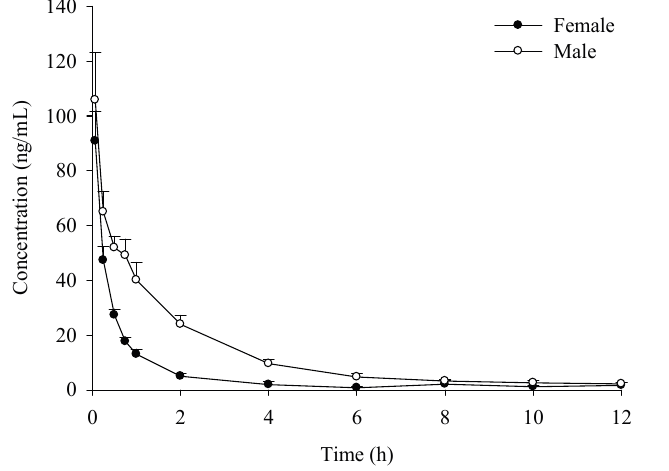
Figure 3. Time-concentration profiles of verticinone after i.v. administration of 0.4 mg/kg.